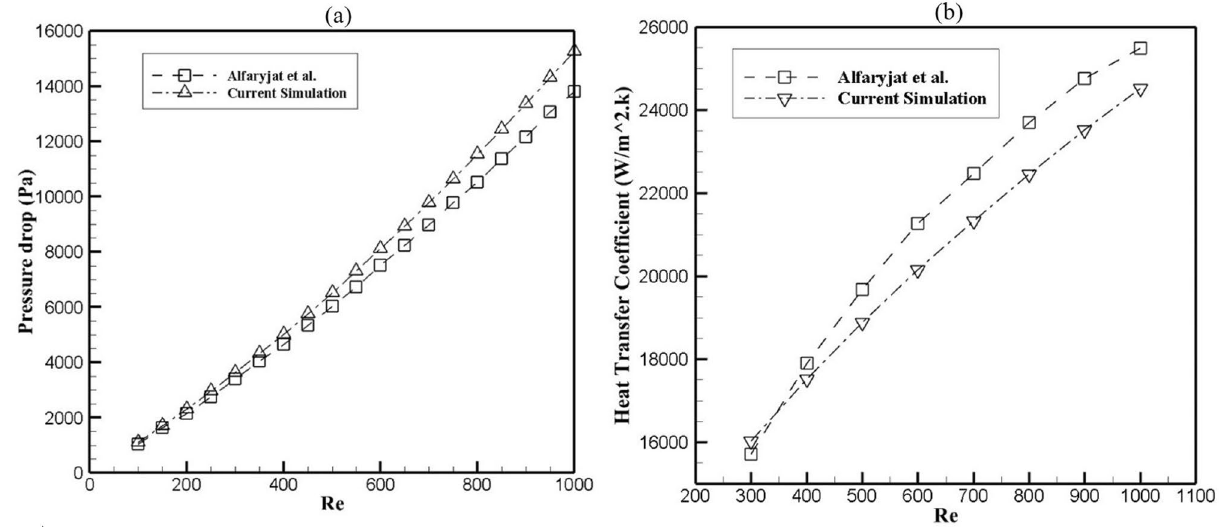
Figure 3. Validation of ( a ) Pressure drop and ( b ) Heat transfer coefficient at different Reynolds numbers with Alfaryjat et al. 22 .